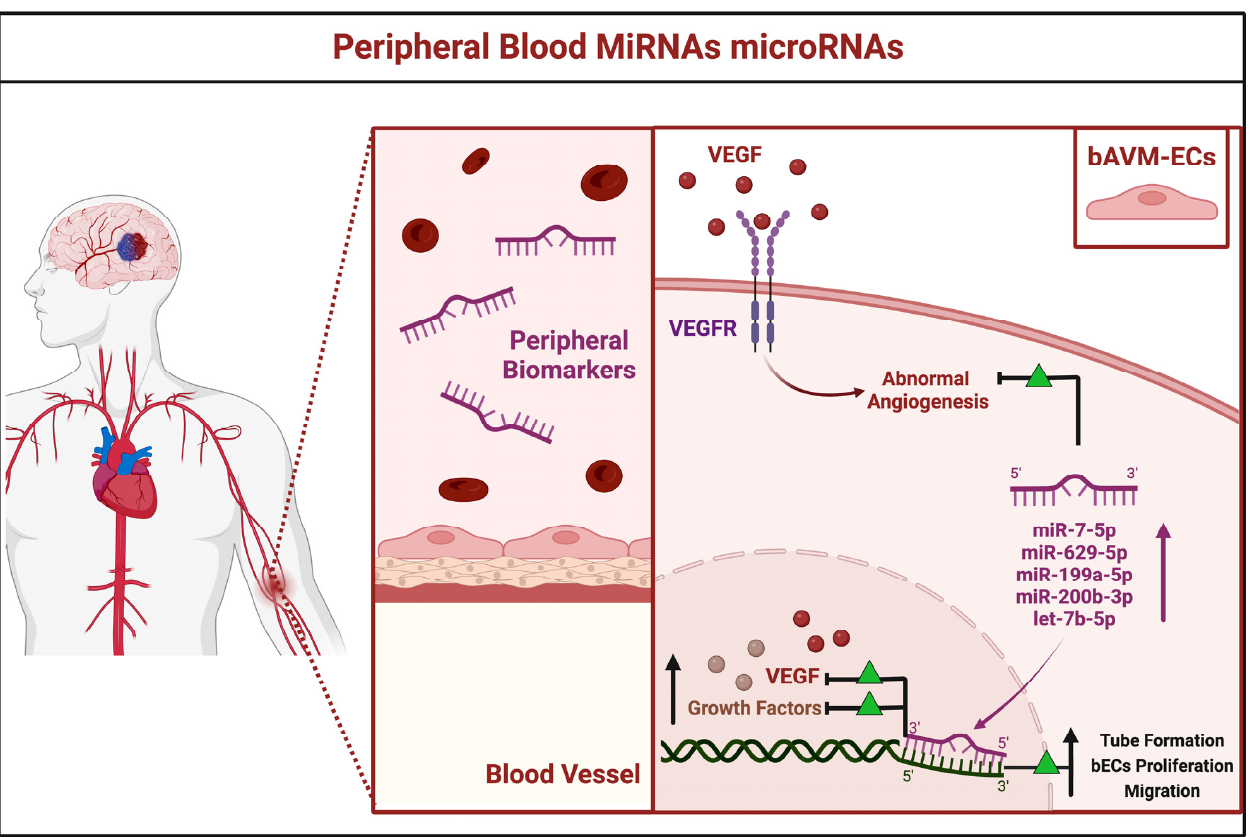
Figure 5. Schematic representation of the peripheral blood microRNAs. The microRNA-7-5p, miR- 629-5p, miR-199a-5p, miR-200b-3p, and let-7b-5p are found raised in the serum to be identifiable as peripheral biomarkers. They regulate multiple pathways involved in the vascular re-arrangement, bAVMs growth, and inflammation processes, via the activation of vascular endothelial growth factor (VEGF), vascular endothelial growth factor receptor (VEGFR), and growth